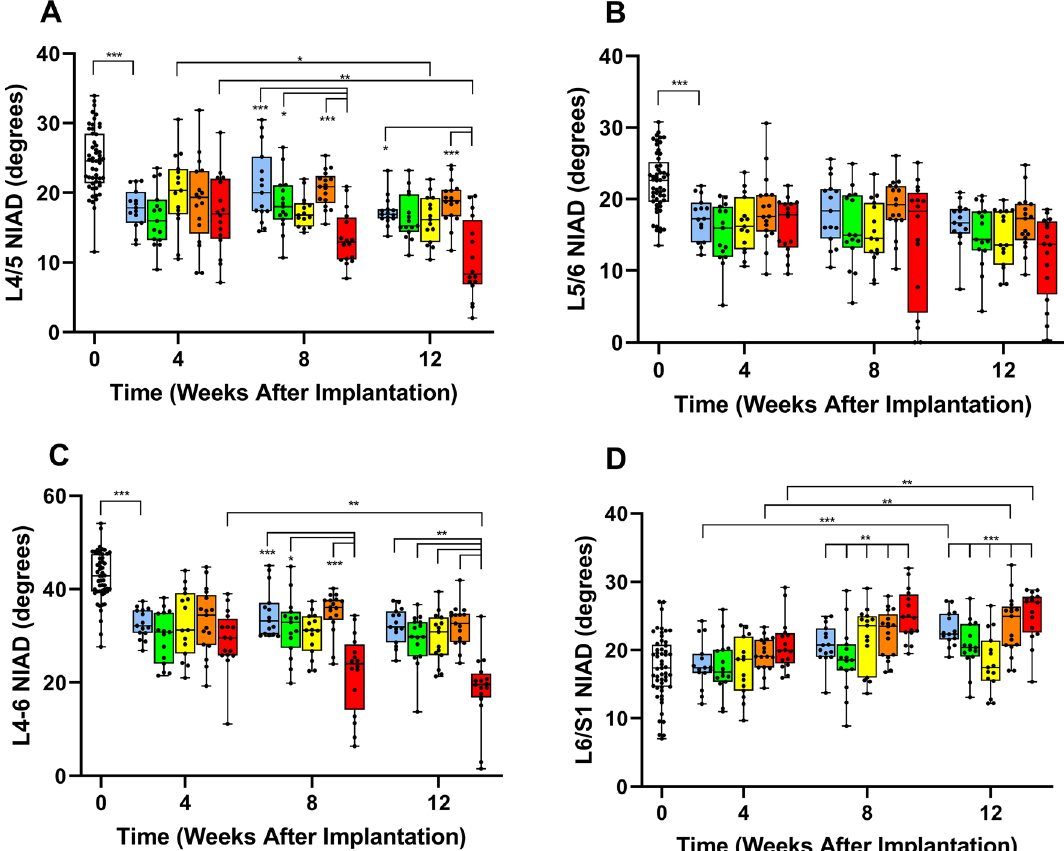
Figure 1. Coronal noninvasive in vivo angular displacement (NIAD) of rat lumbar motion segments had the greatest decline in mobility for the BMP2/7 heterodimer (HT)-treated spines at ( A ) lumbar 4/5 (L4/5), ( B ) L5/6, and ( C ) combined L4-6 segment at 4, 8 and 12 weeks following intradiscal administration of genetically- programmed bone marrow stromal cells. ( D ) Increased mobility was detected in all groups at the L6/S1 segment over the same time course, likely due to stiffening at the L4-6 levels. Time of assessment (horizontal axis) and treatment (white square is Naïve, blue square is LACZ, green square is BMP2, yellow square is BMP7, orange square is mixed BMP2 and BMP7 [homodimers, HM], red square is BMP2/7 [heterodimers, HT]) are indicated. Individual data points are shown, box plots represent treatment-group median, 25th and 75th percentiles and